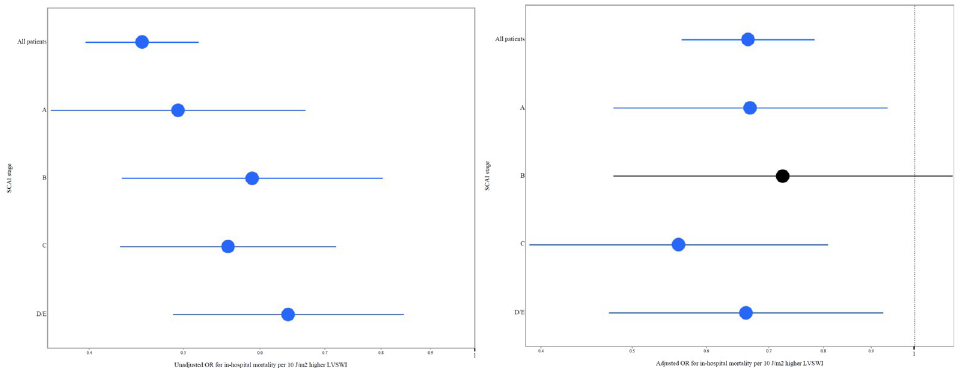
Fig 5. Forest plots showing unadjusted (left) and adjusted (right) odds ratio (OR) values for ECHO-LVSWI (per each 10 J/m 2 higher) overall and in each SCAI shock stage.